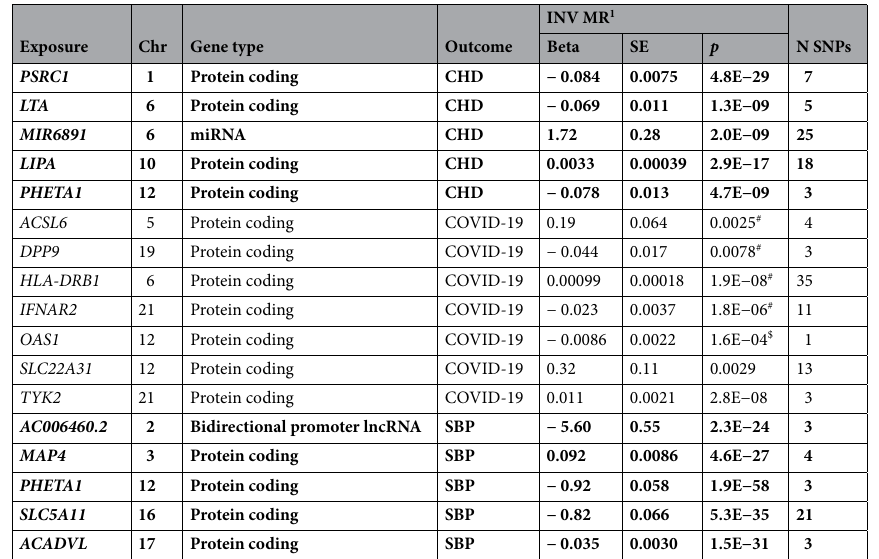
Table 4. Top results in Mendelian randomization analyses. 1 Beta/SE and p-value were obtained by inverse variance weighted MR method. # Heterogeneity was observed in MR analyses. Sensitivity analyses were performed with median-based and mode-based MR methods in Supplemental Table 9. $ MR analysis was performed at gene level. At splice variation level (rs10774671), the MR p =